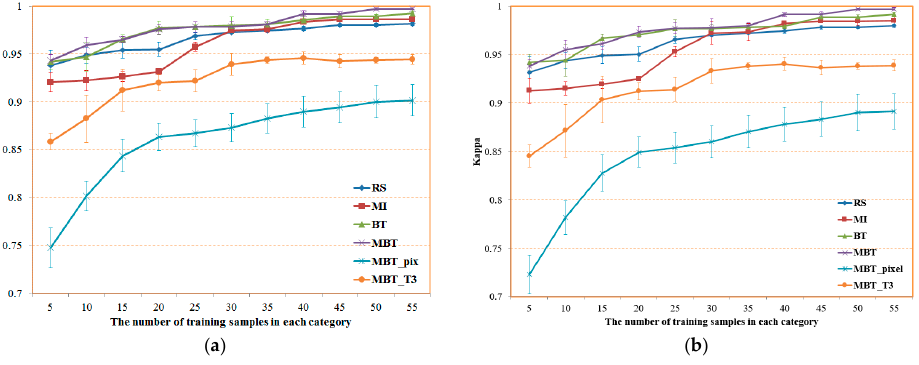
Figure 5. OA and Kappa curves with different numbers of training samples from different strategies: ( a ) OA; ( b )